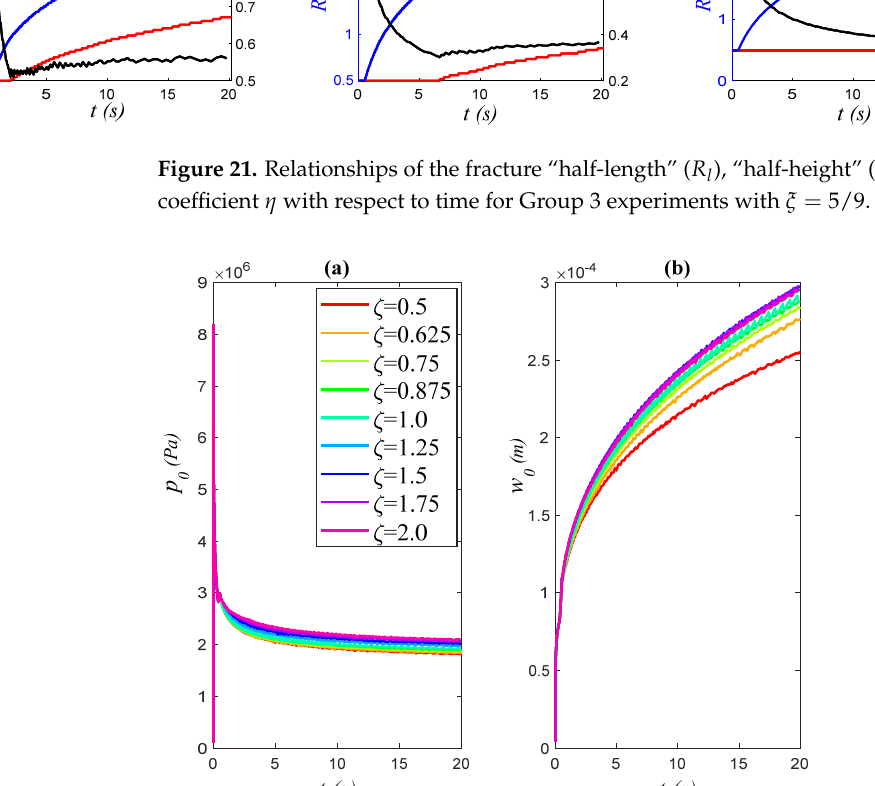
Figure 21. Relationships of the fracture “half-length” ( 𝑅 (cid:3039) ), “half-height” ( 𝑅 (cid:3035) ) and the fracture shape coefficient 𝜂 with respect to time for Group 3 experiments with 𝜉 = 5 9⁄ .